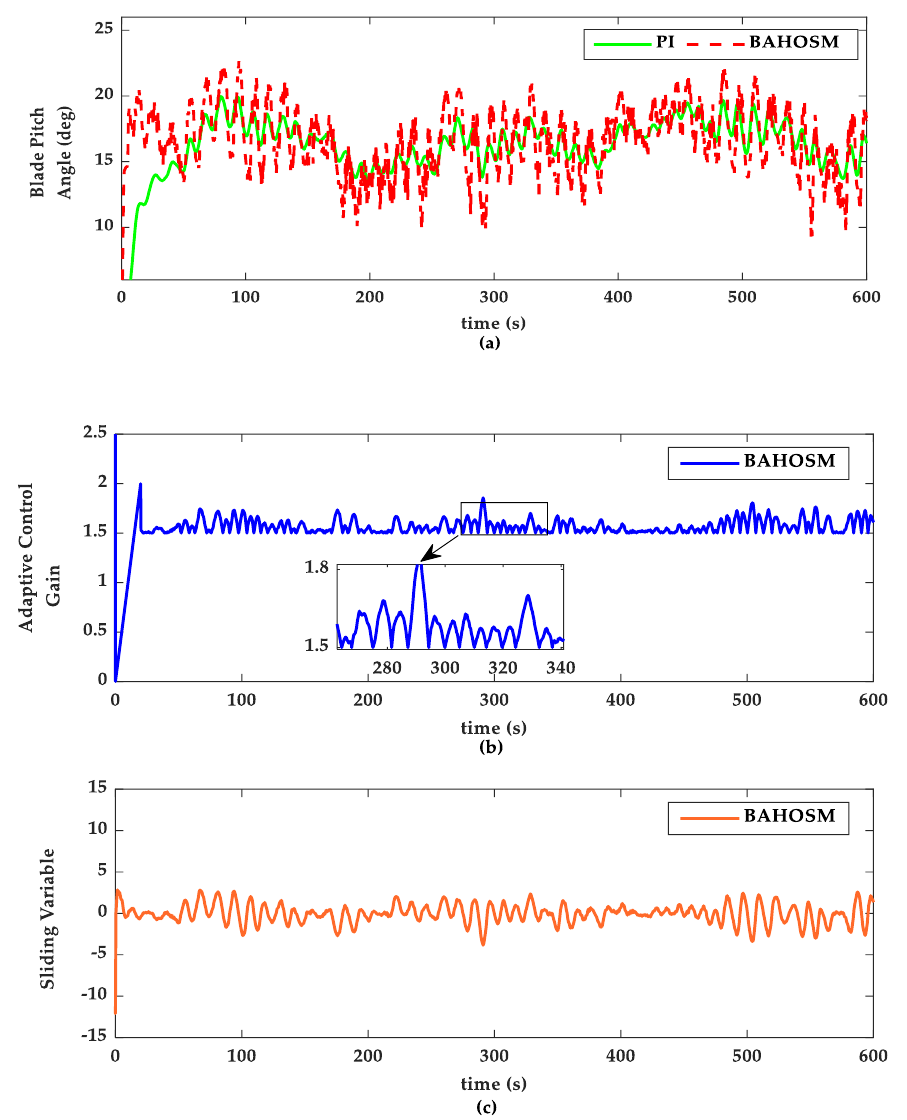
Figure 12. Blade pitch angle output ( a ) by BAHOSM controller gain L ( b ) and sliding variable s ( c ) in Case 2.